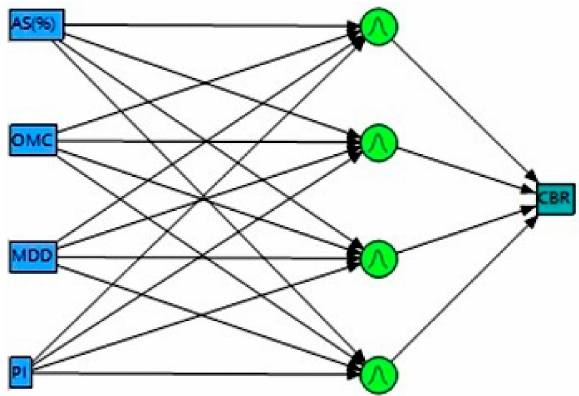
Figure 4. Artificial Neural Networks (ANNs) structure of CBR Prediction.